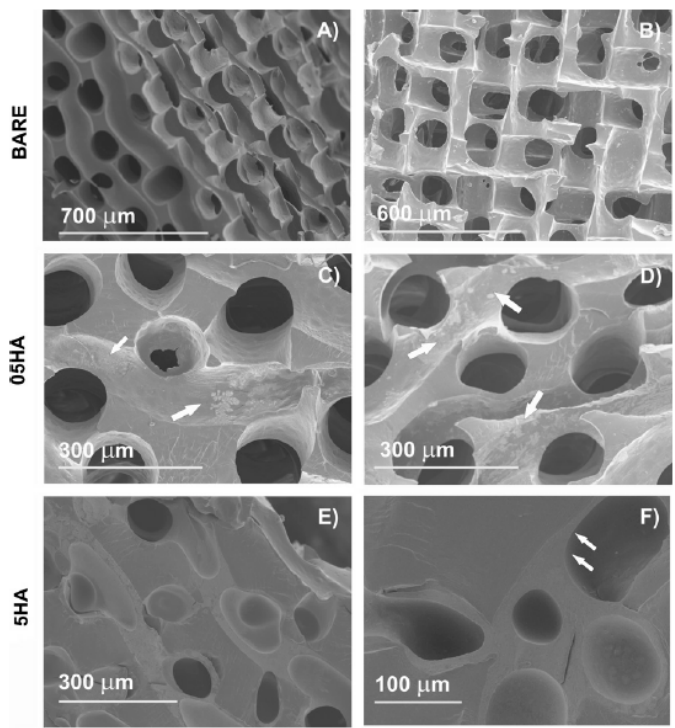
Figure 4. Scanning electron microscopic images of the dry poly(ethyl acrylate)(PEA) scaffolds: ( A and B ) Bare scaffold, cross section, and frontal view, respectively; ( C ) 05HA1; ( D ) 05HA5; ( E ) 5HA2; ( F ) 5HA5. The arrowheads point at the adsorbed HA. With one coating cycle, 0.5 wt% HA solution produced aggregates on the pore surface (shown in C ). These aggregates become more distinct as the number of cycles increases, but a uniform layer is not obtained with 0.5wt% even after five cycles ( D ). In contrast, coating with 5wt% HA produces a uniform continuous layer after the first coating